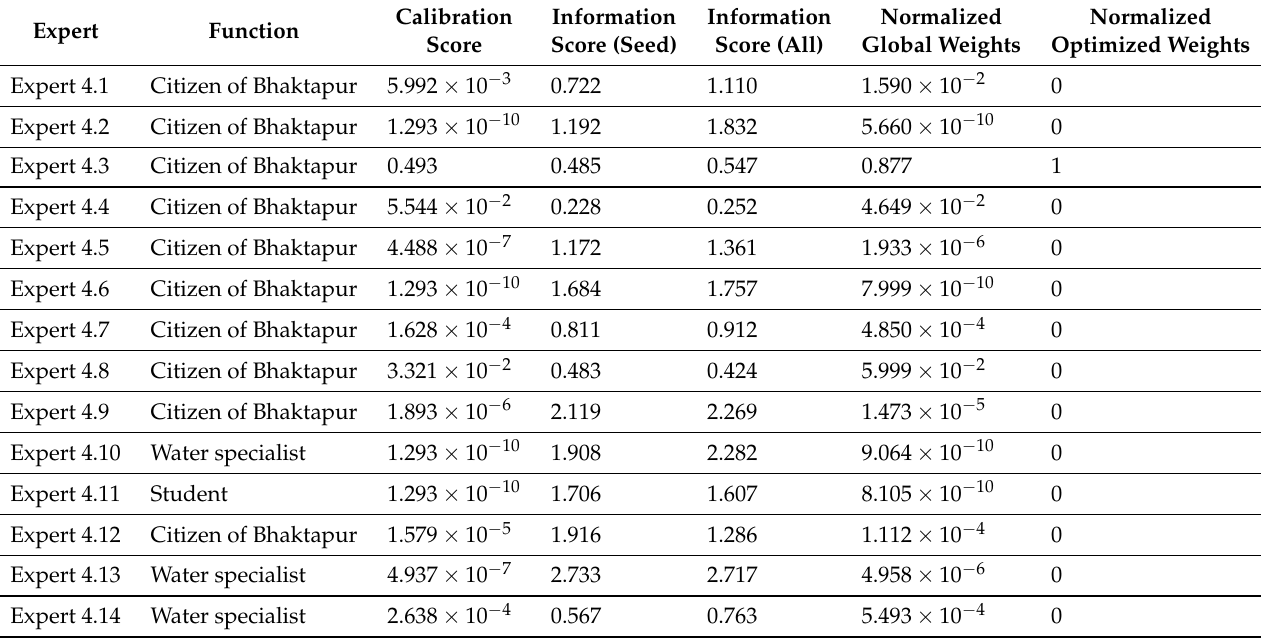
Table A5. Calibration and Information scores for the experts of panel